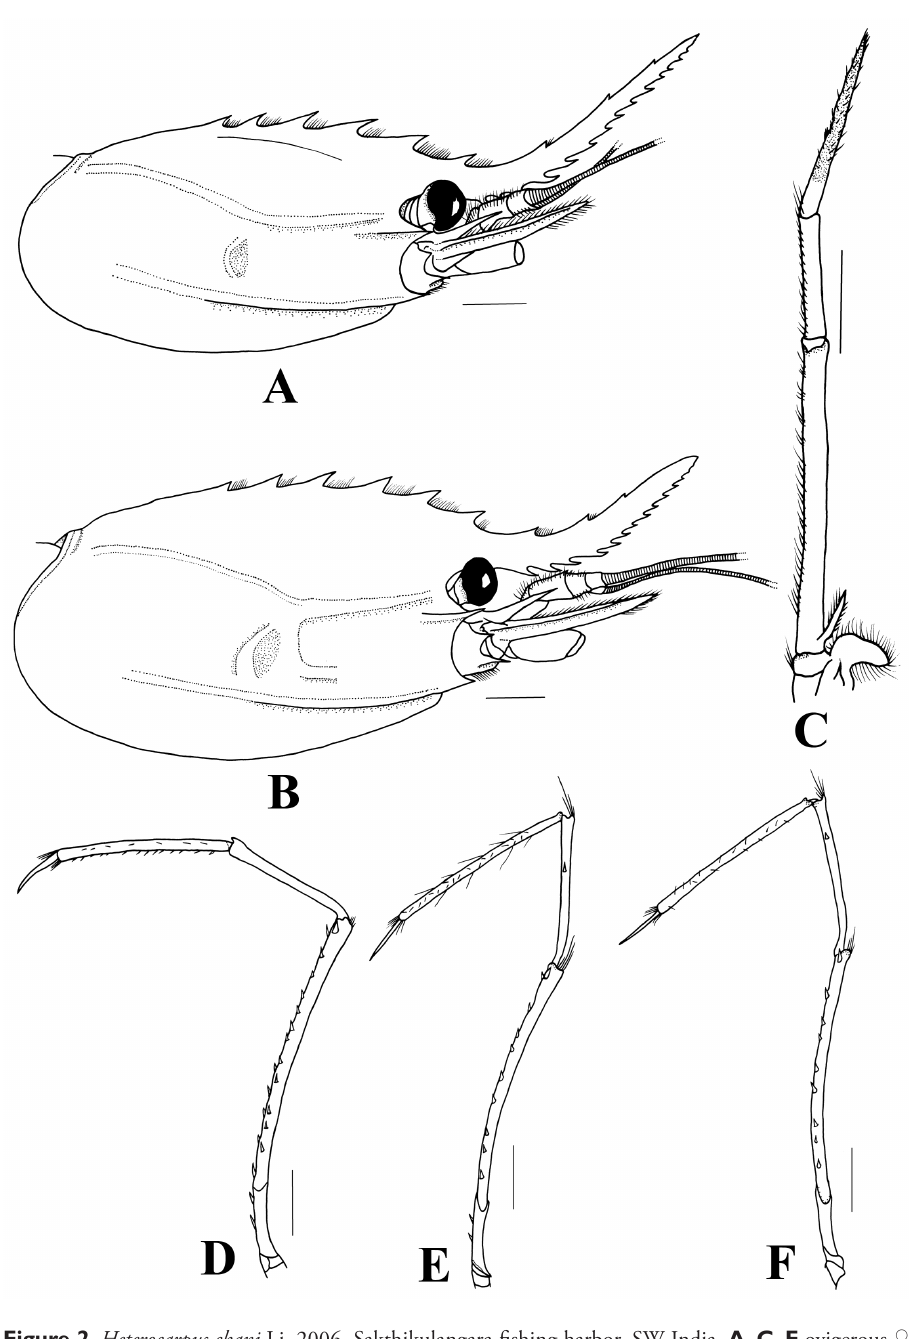
Figure 2. Heterocarpus chani Li, 2006, Sakthikulangara fishing harbor, SW India. A, C–F ovigerous ♀ cl 26.8 mm (NTOU M02050) B ovigerous ♀ cl 31.4 mm (NTOU M02050) A–B Carapace, lateral C right maxilliped III D right pereiopod III E right pereiopod IV F right pereiopod V. Scales = 5